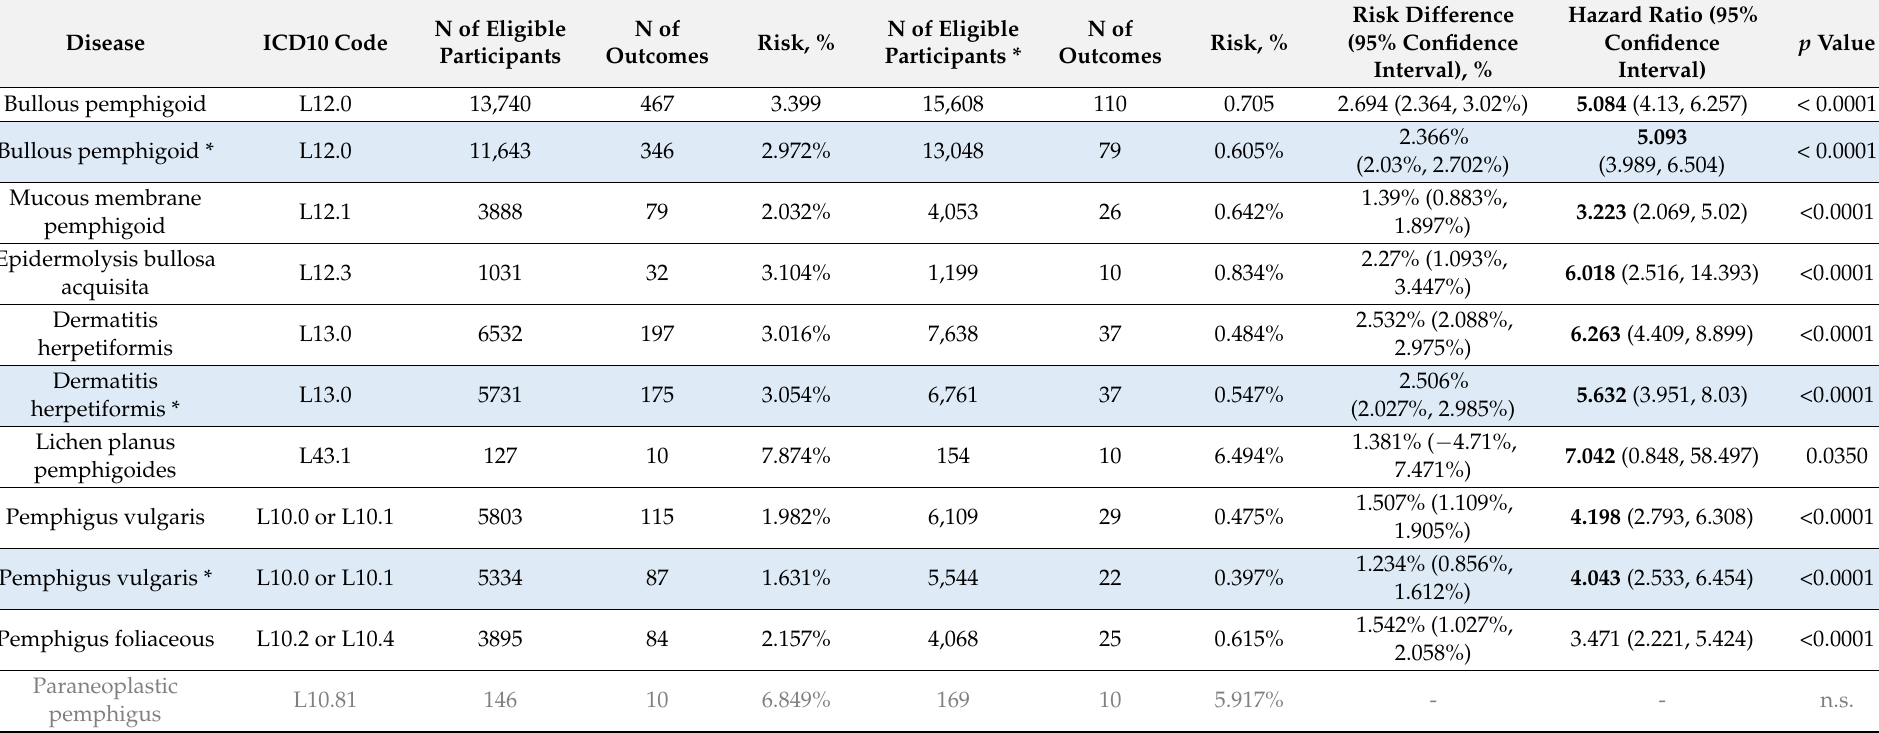
Table 5. Pemphigus and pemphigoid diseases are associated with an increased risk for pruritus. The risk probability of pruritus in individuals diagnosed with any pemphigus or pemphigoid disease (cases) compared to those without the diagnosis of any pemphigus or pemphigoid disease (controls) within 6 months after the diagnosis of any pemphigus or pemphigoid disease. Data shown display results from measures of association, excluding patients with outcome prior to the time window for the hazard ratio. Kaplan-Meier analysis (again excluding patients with outcome prior to the time window) with log-rank test was